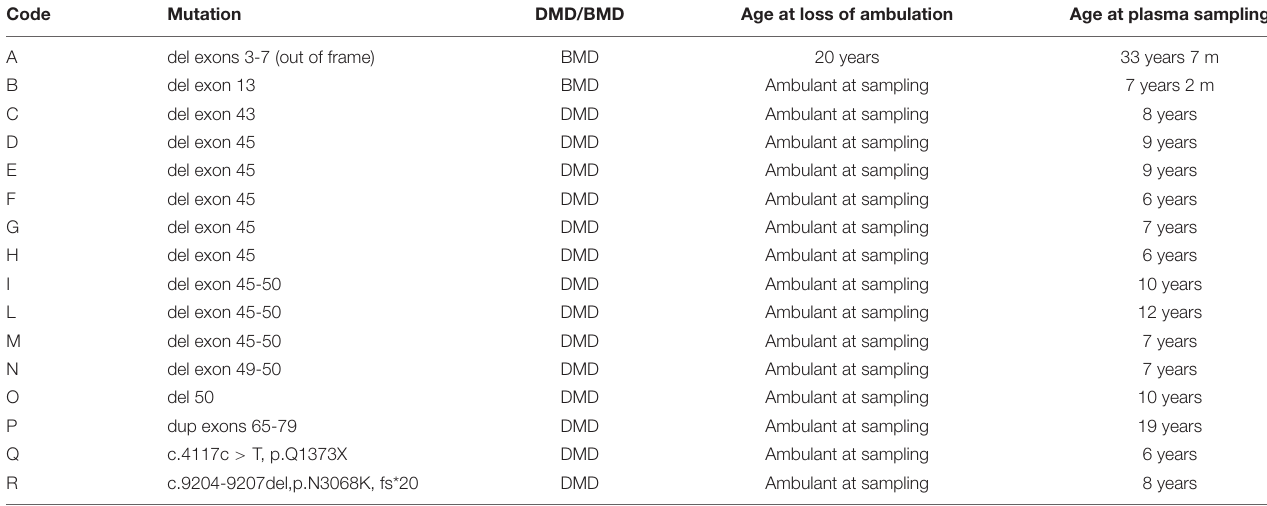
TABLE 4 | Selected patients for Csnk1 ε protein quantification in